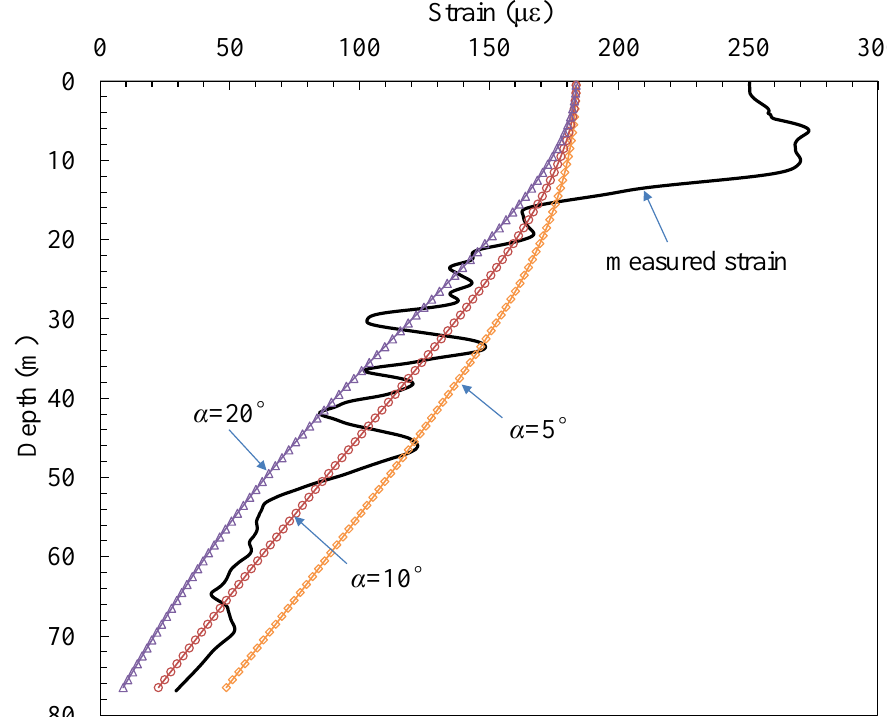
14 of 23 Figure 10. Determination of the load at the pile head by the minimum Euclidean distance. 3.2. Interpretation of Measured Data To interpret measured strain data using the methodology presented in the previous section, it was important to determine the ultimate skin friction between the soil and the pile, which is usually calculated using